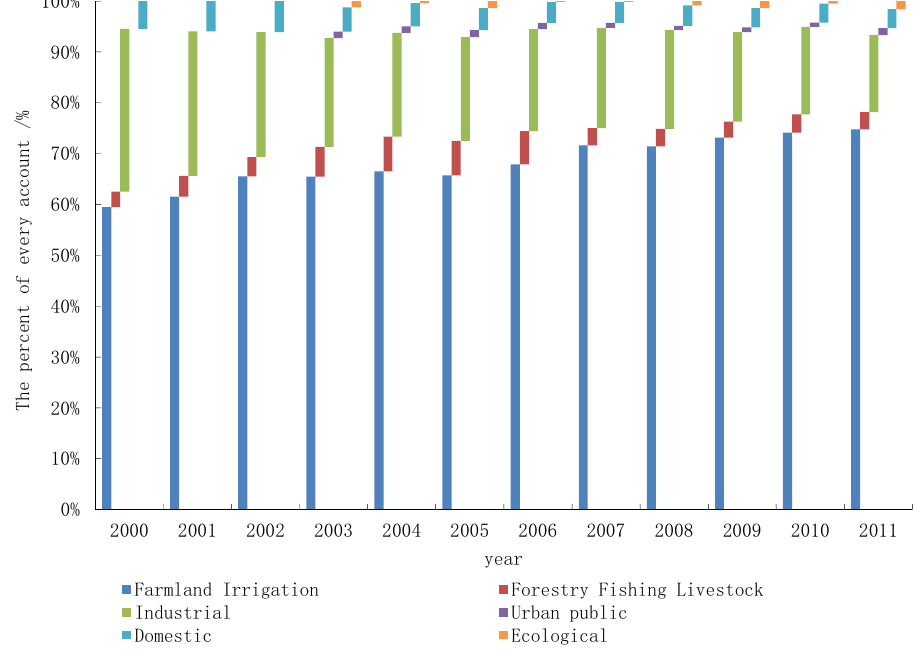
Fig. 8 EF accounts of water resources in Heilongjiang